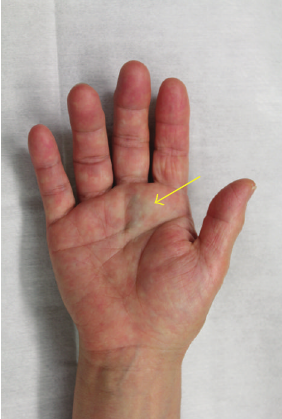
Figure 1: A bluish tumor of 30 mm in diameter was observed on the palm of her right hand.